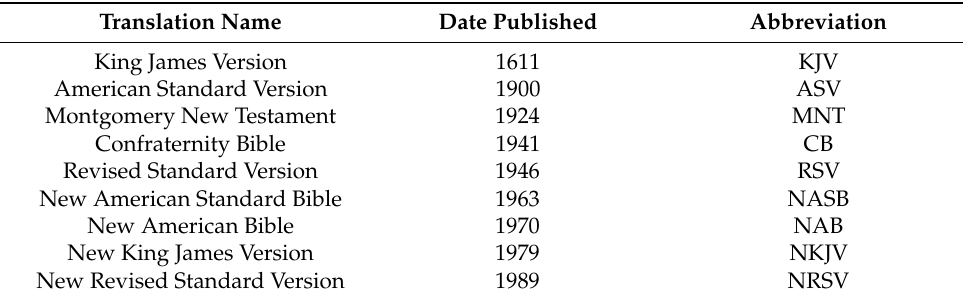
Table 1. English bible translations and the standard